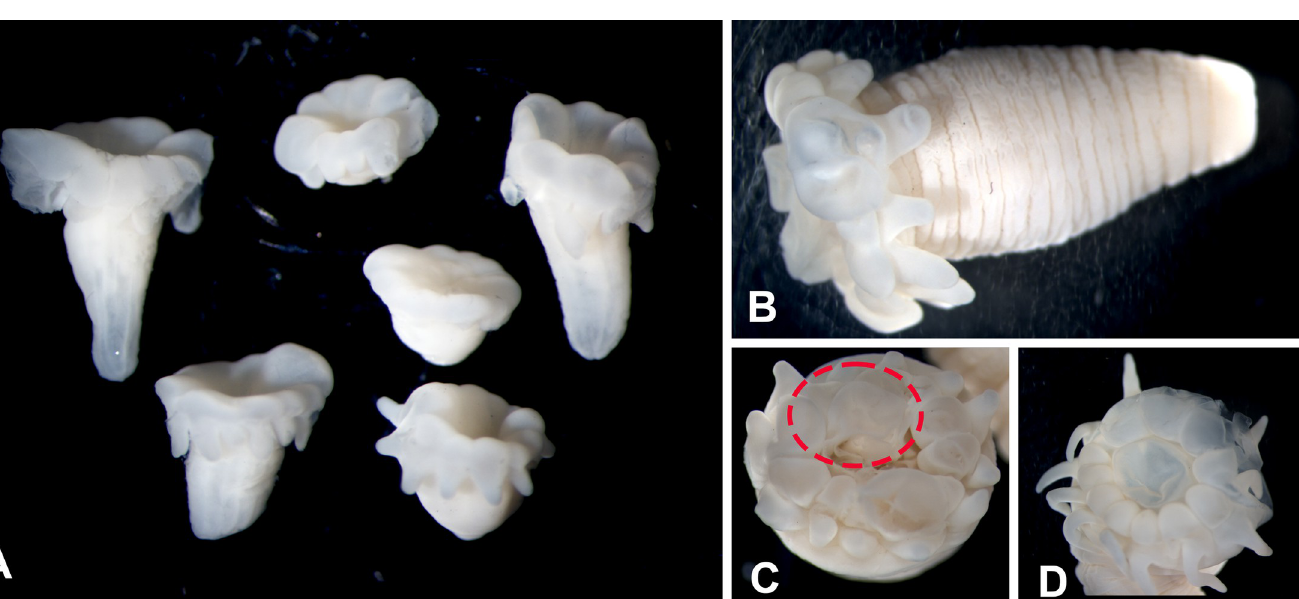
data sets. Clade 1 consists of Anemonactis minuta , Haloclava producta , and Haloclava sp. Because previous datasets did not include any species of Anemonactis , this finding is new, but it reflects long-recognized similarities between these genera [see, e.g., [65]]. Inclusion of Ha .